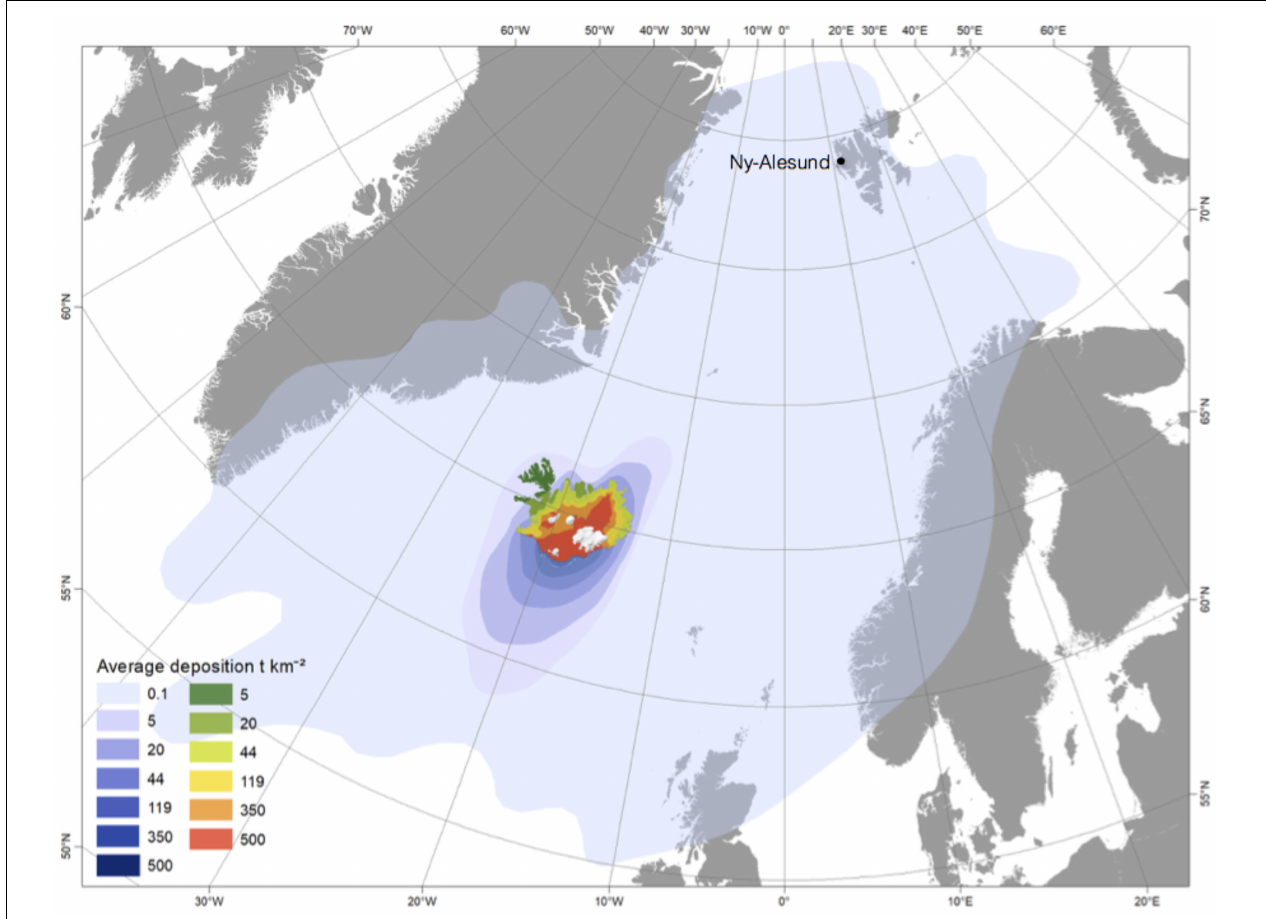
FIGURE 1 | Map of average distributions of dust and volcanic ash around Iceland with main dust sources in Iceland. The map is extended from the dust depostion map by Arnalds et al. (2014) including low dust deposition class from the calculations of Groot Zwaaftink et al. (2017).